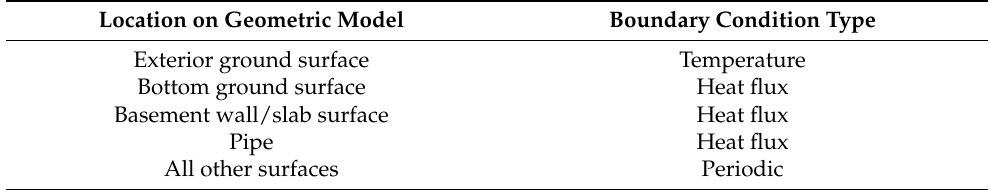
Table 2. Boundary